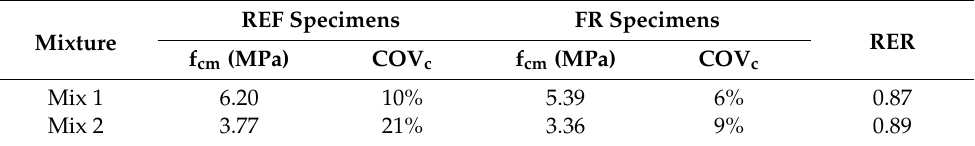
Table 5. Results of compression strength of NC specimens according to the type of mixture.